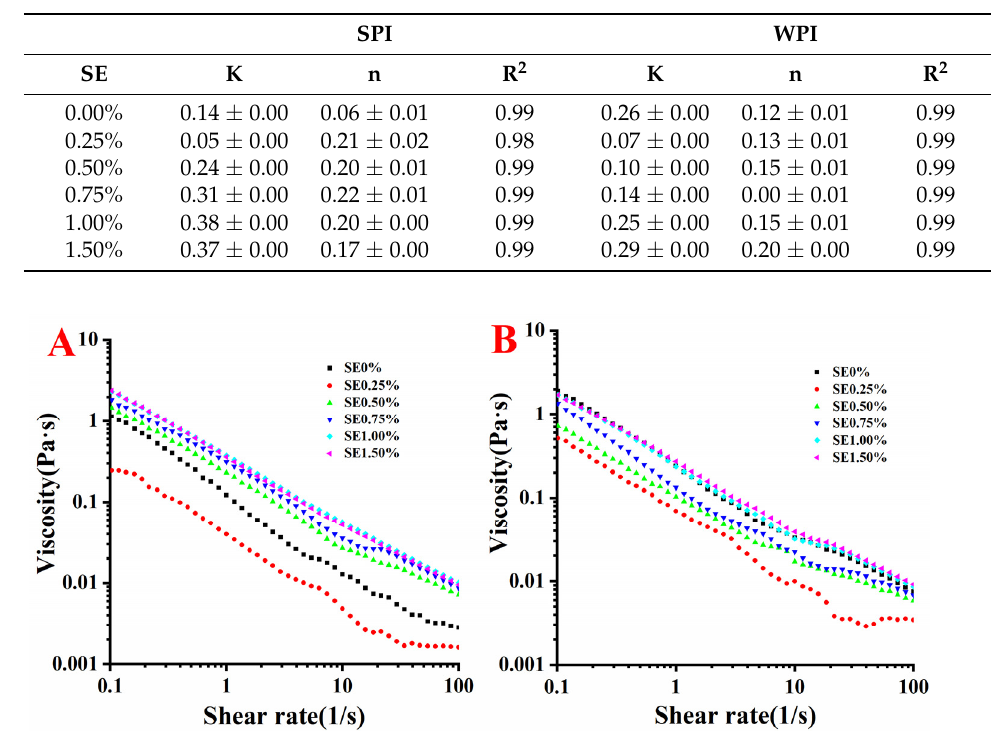
Figure 4. Viscosity of the emulsions at different SE concentration (( A ): SPI; ( B ): WPI).